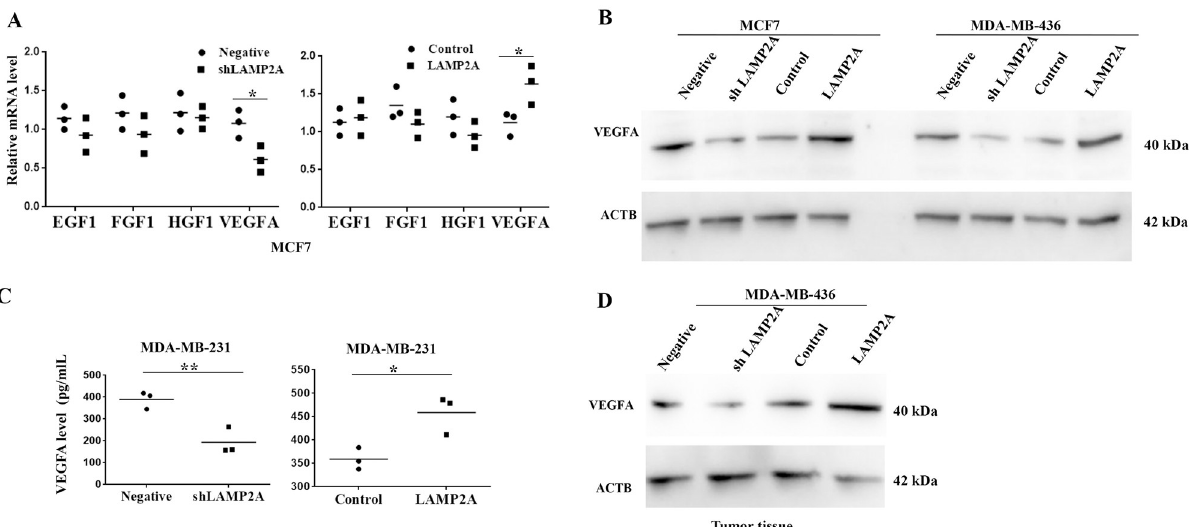
Fig 5. CMA promoted VEGFA expression of breast cancer cells. (A) VEGFA mRNA expression level was detected by real-time PCR in breast cancer cell line MCF7 after LAMP2A knockdown or overexpression. (B) The protein expression level of VEGFA was measured by Western blotting in MCF7 cells and MDA-MB-436 cells after LAMP2A knockdown or overexpression. (C) VEGFA level was detected by ELISA in breast cancer cell line MDA-MB-231 after LAMP2A knockdown or overexpression. (D) The protein expression level of VEGFA was measured by Western blotting in MDA-MB-436 xenograft tumor models after LAMP2A knockdown or overexpression. MDA-MB-436 cells with different LAMP2A expression, were subcutaneously injected into nude mice at 1 × 10 7 cells/mouse. All values are representative of three different experiments; � P < 0.05, �� P < 0.01.